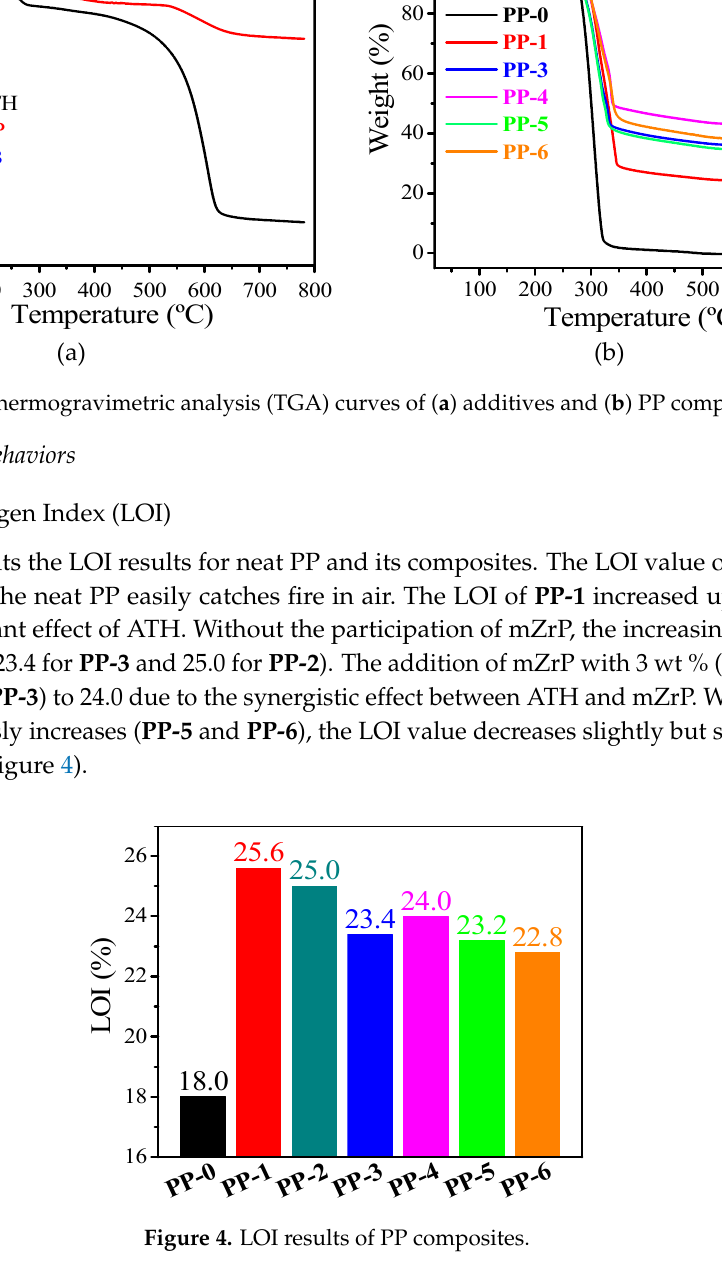
Figure 4. LOI results of PP composites.